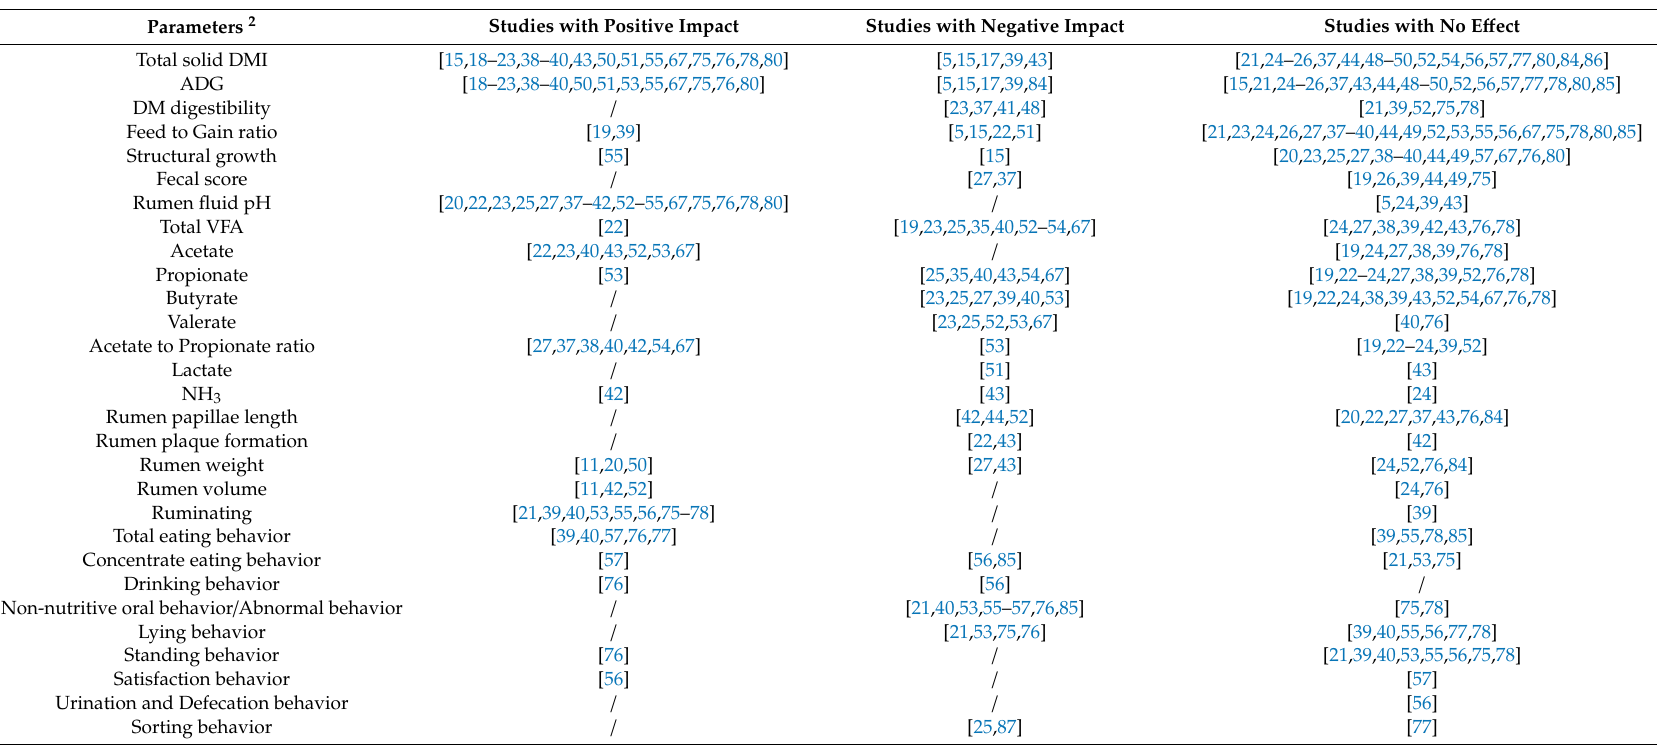
Table 7. Summary of selected studies on forage inclusion and their e ff ect on performance, rumen fermentation, and expressive behavior compared to calves fed only concentrates 1